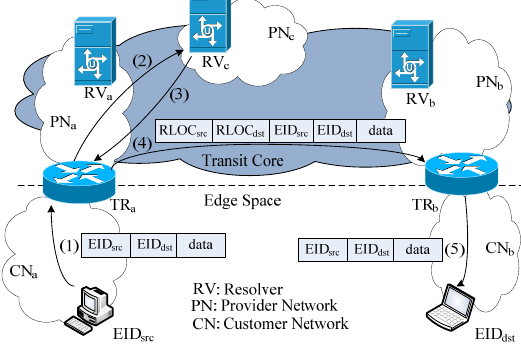
Fig. 1. Illustration for network model with locator/identifier